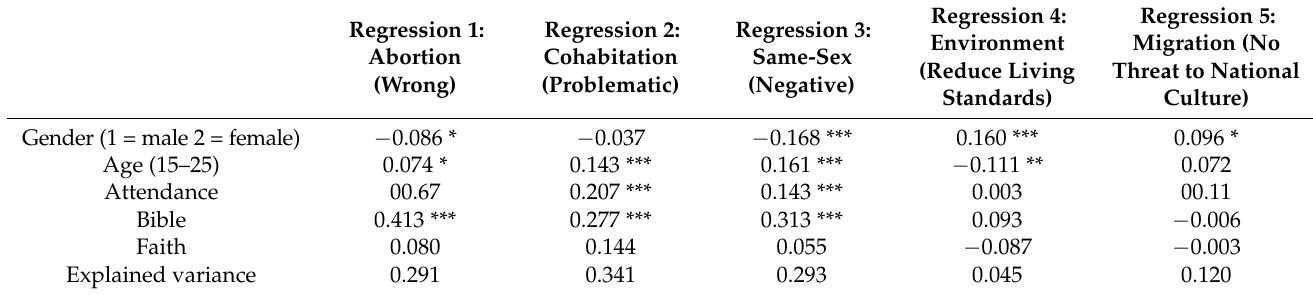
Table 2. Young evangelicals in Norway. Linear regression analyses with five political values as dependent variables. Pearson’s